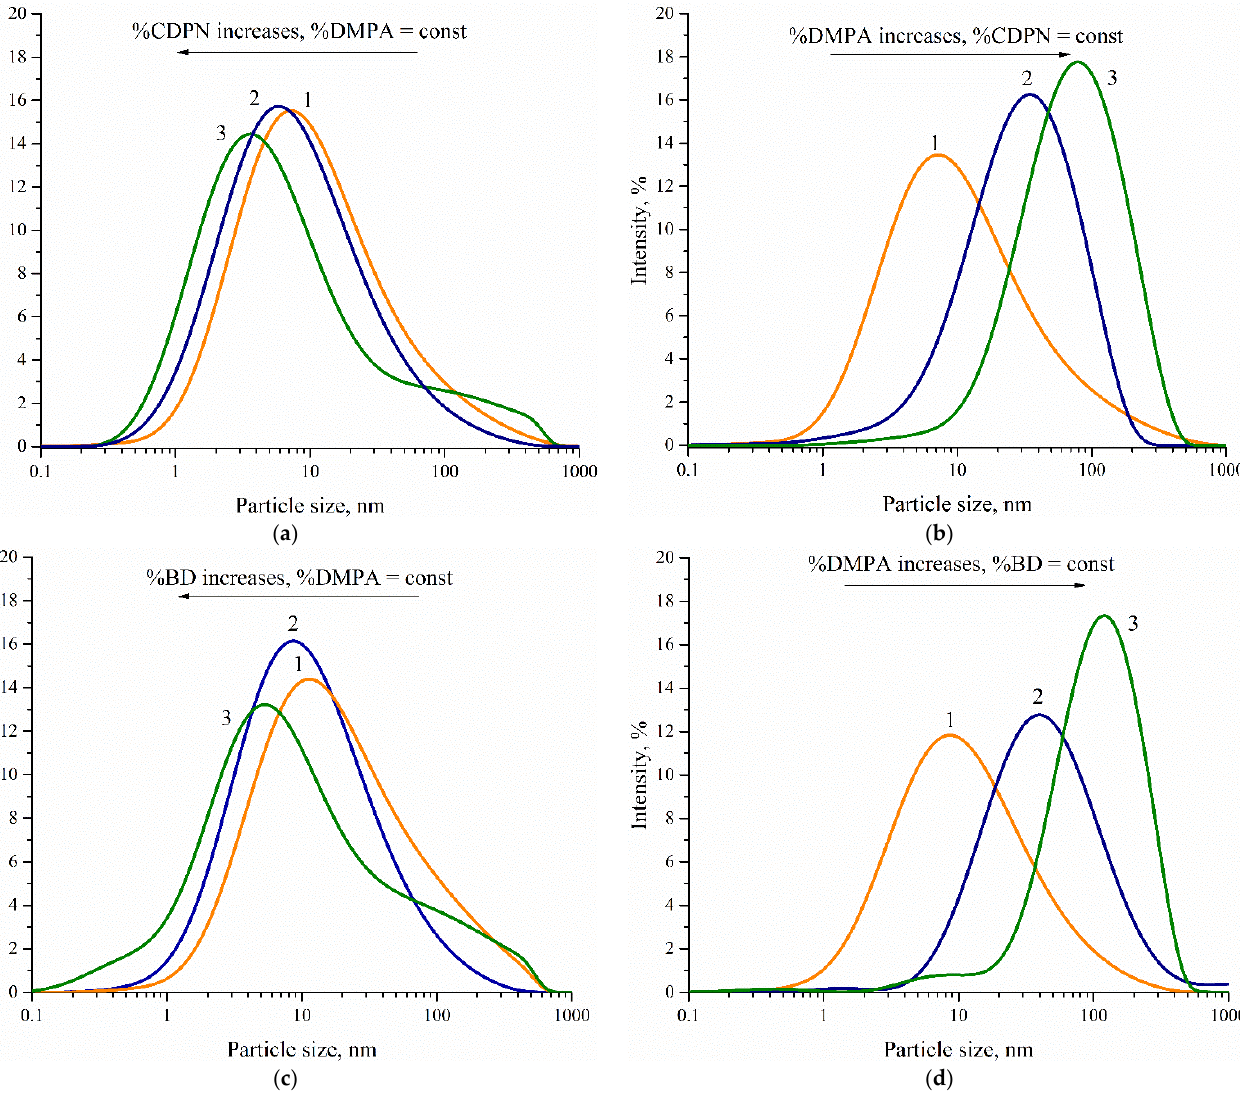
Figure 5. Typical curves of dispersed phase particle size distribution in WPU dispersion: ( a ) 1—sample 1.1, 2—sample 1.2, 3—sample 1.3; ( b ) 1—sample 1.1, 2—sample 1.4, 3—sample 1.7; ( c )